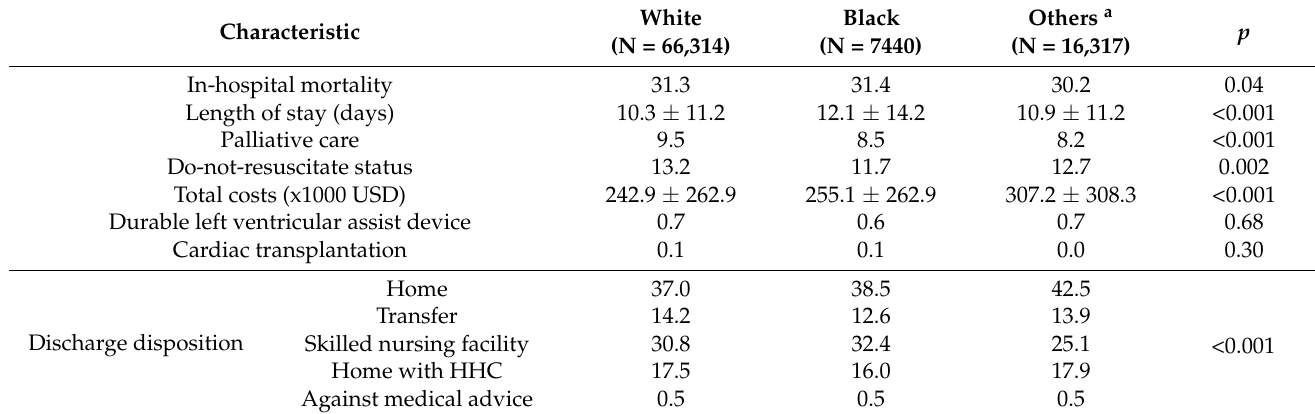
Table 2. Clinical outcomes of AMI-CS admissions receiving MCS in race